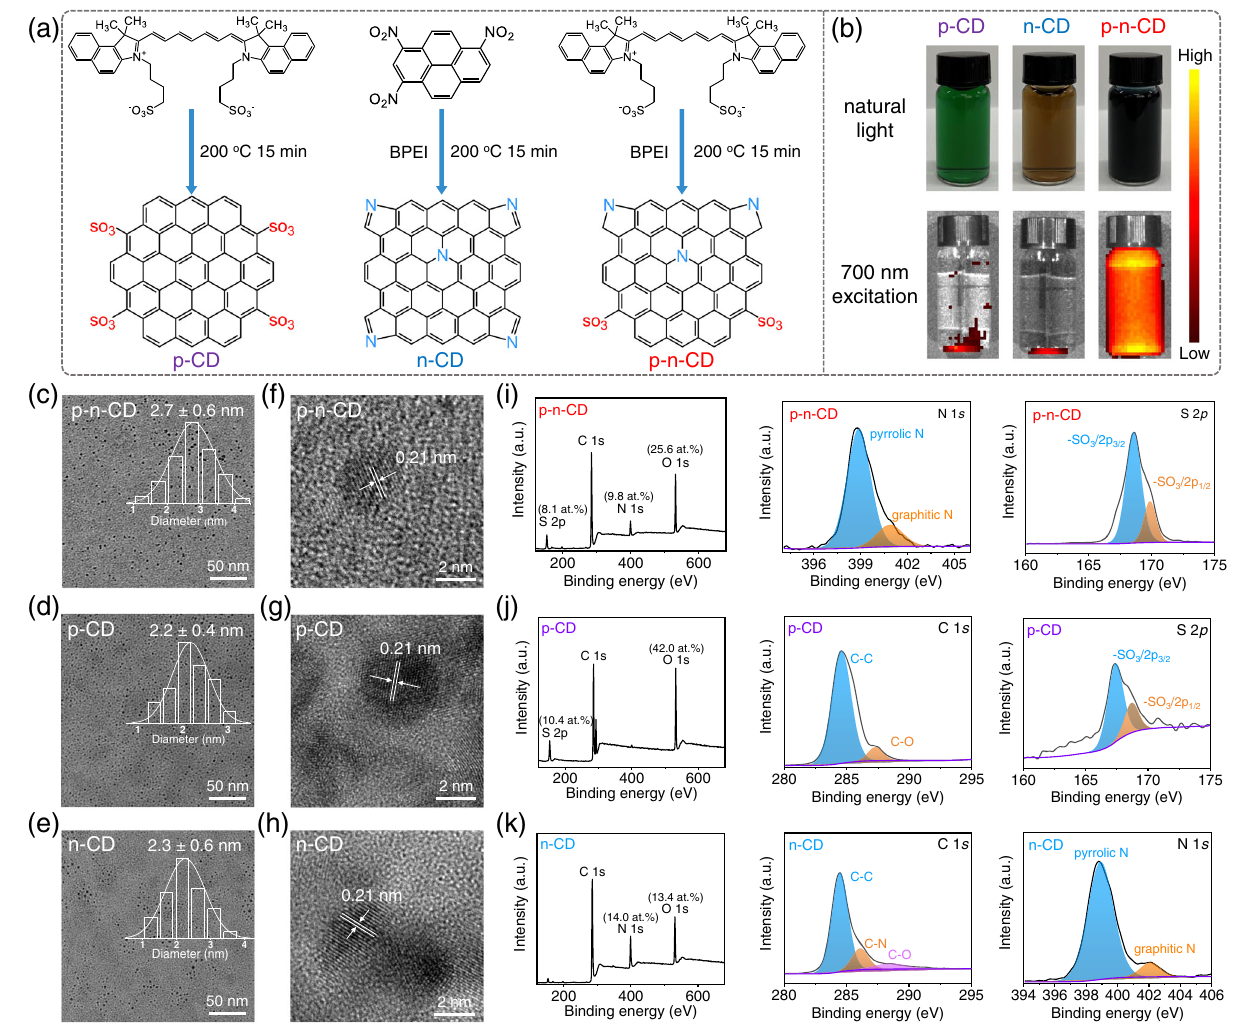
Fig. 2 | Synthesis and characterization of p-CDs, n-CDs, and p – n-CDs. a Microwavesynthesisroutesofp-CDs,n-CDs,orp – n-CDsusingICG,TNP+BPEI, orICG+BPEIastheprecursor,respectively. b PhotographsandNIR fl uorescence images ofp-CDs, n-CDs, and p – n-CDs under natural lightand 700nm excitation, respectively. c – e TEM images andcorrespondinglateralsizedistributionofp – n-